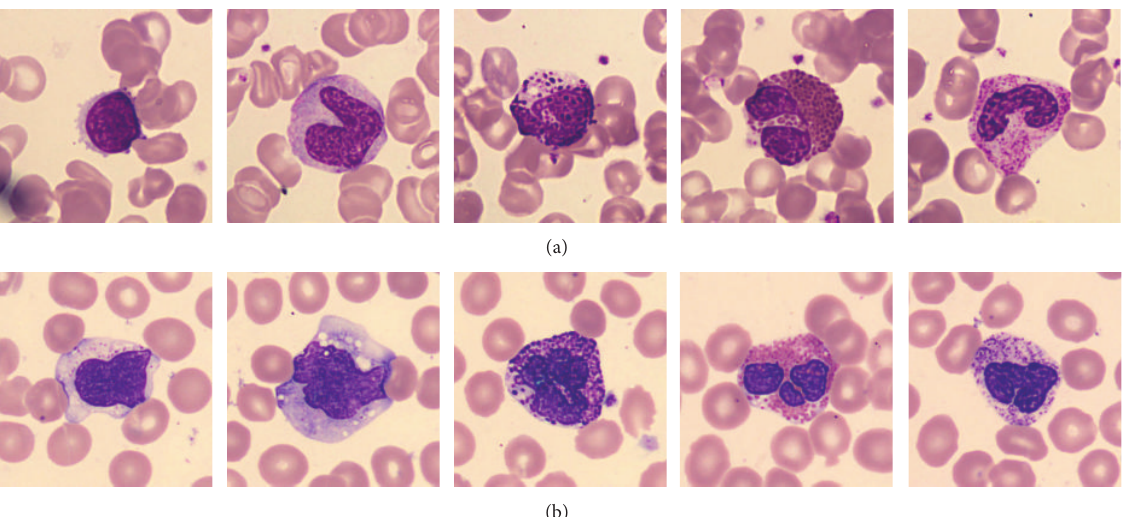
Figure 4: Samples of white cell images from the CellaVision Competency Software Databases. From left to right, lymphocyte, monocyte, eosinophil, basophil, and neutrophil. (a) Data set 1. (b) Data set 2.